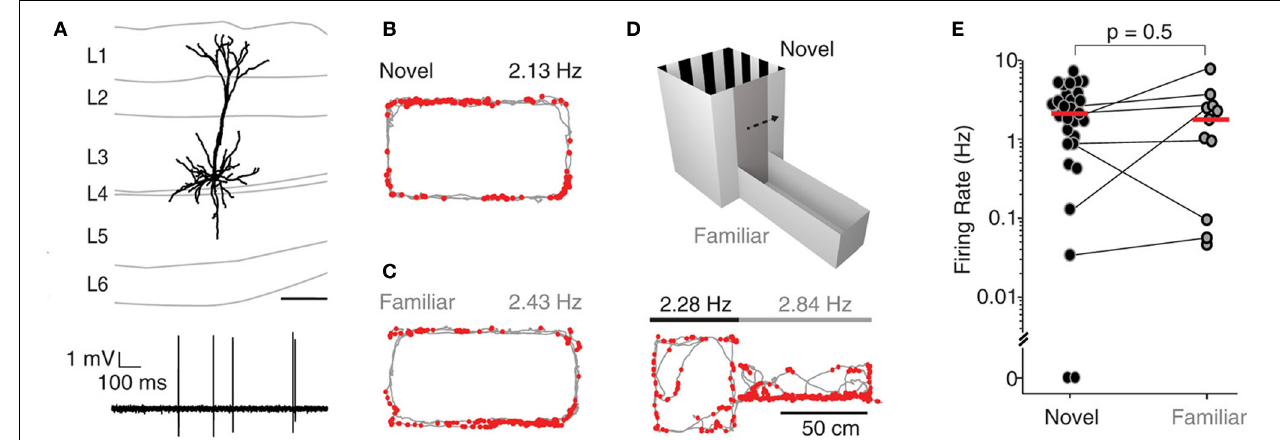
FIGURE 2 | Superficial layer neurons in MEC fire at higher rates irrespective of spatial experience. (A) Top, reconstruction of the dendritic morphology of the L3 neuron of MEC recorded during exploration of a familiar O-maze [recording shown in (C) ]. Bottom, representative spike trace. Scale bar = 200 during freely-moving behavior. (B) Firing locations of spikes (red) and trajectory of the rat (gray) during running in a novel environment (O- maze). Average firing rate is indicated. (C) Same as in (B) , but for a familiar environment. (D) Top: the two-compartment maze used for the combined